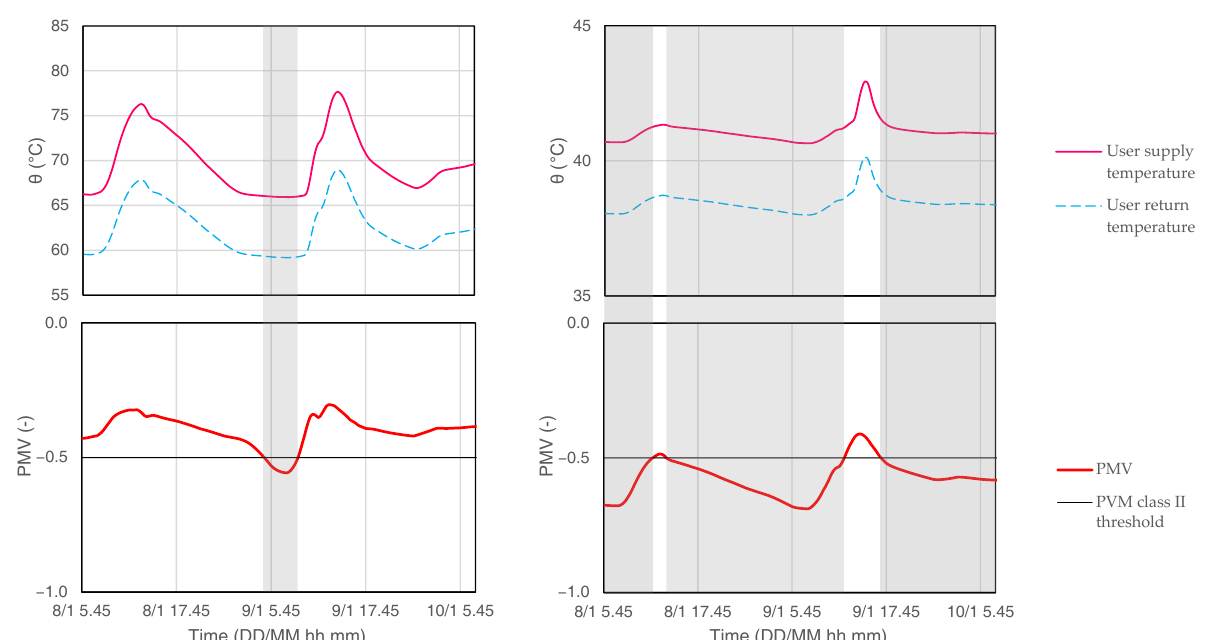
Figure 4. Top: user supply/return temperatures in a winter period in a single family house built before 1900 ( left ) and a single family house built after 2006 ( right ) after decreasing the DH temperature from 115 ◦ C to 88 ◦ C. Bottom: corresponding PMVs. Discomfort periods are indicated by the gray areas.